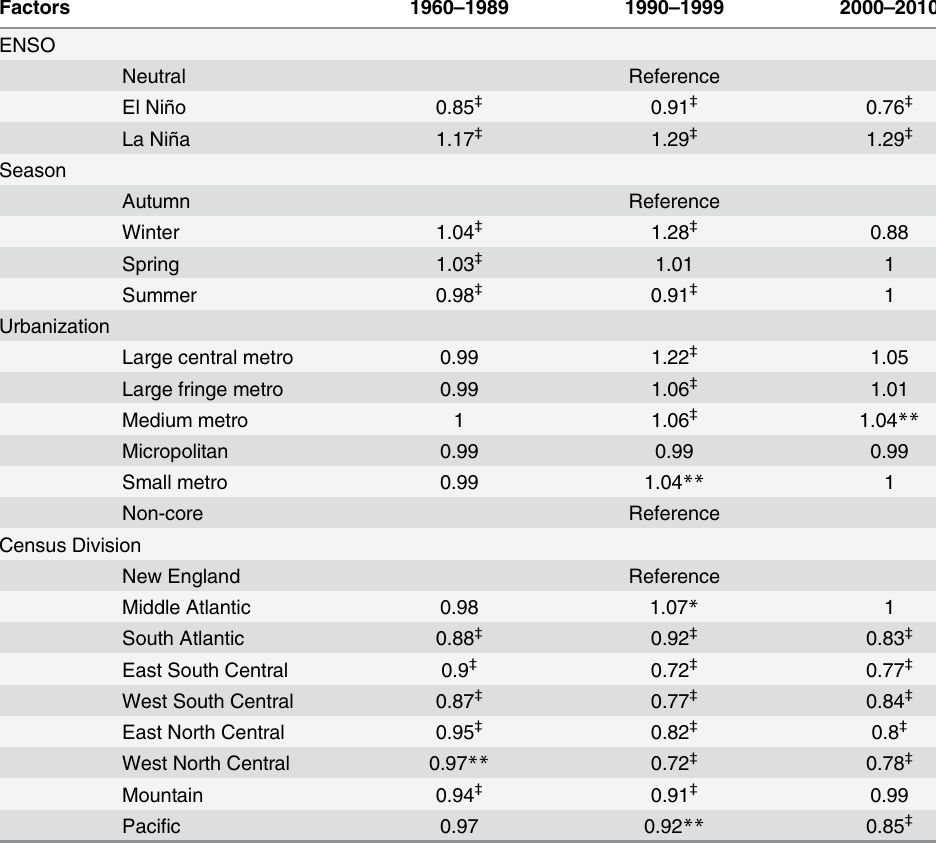
Table 3. Relative percent change in extreme heat events, by time period, for the continental United States, excluding Alaska and Hawaii.